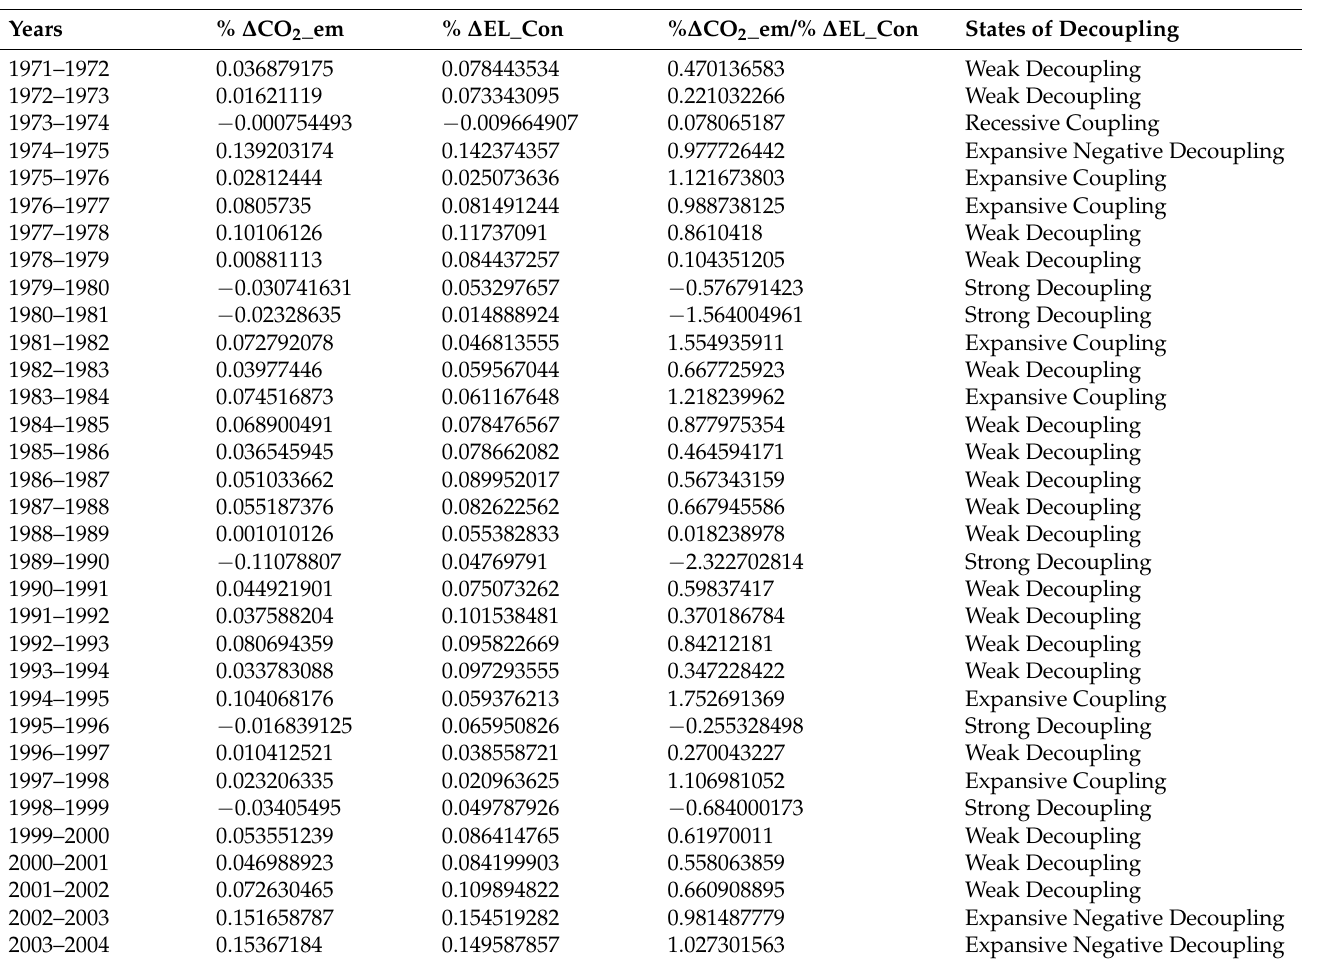
Table 5. The states of decoupling of CO 2 emissions and electricity consumption in China during